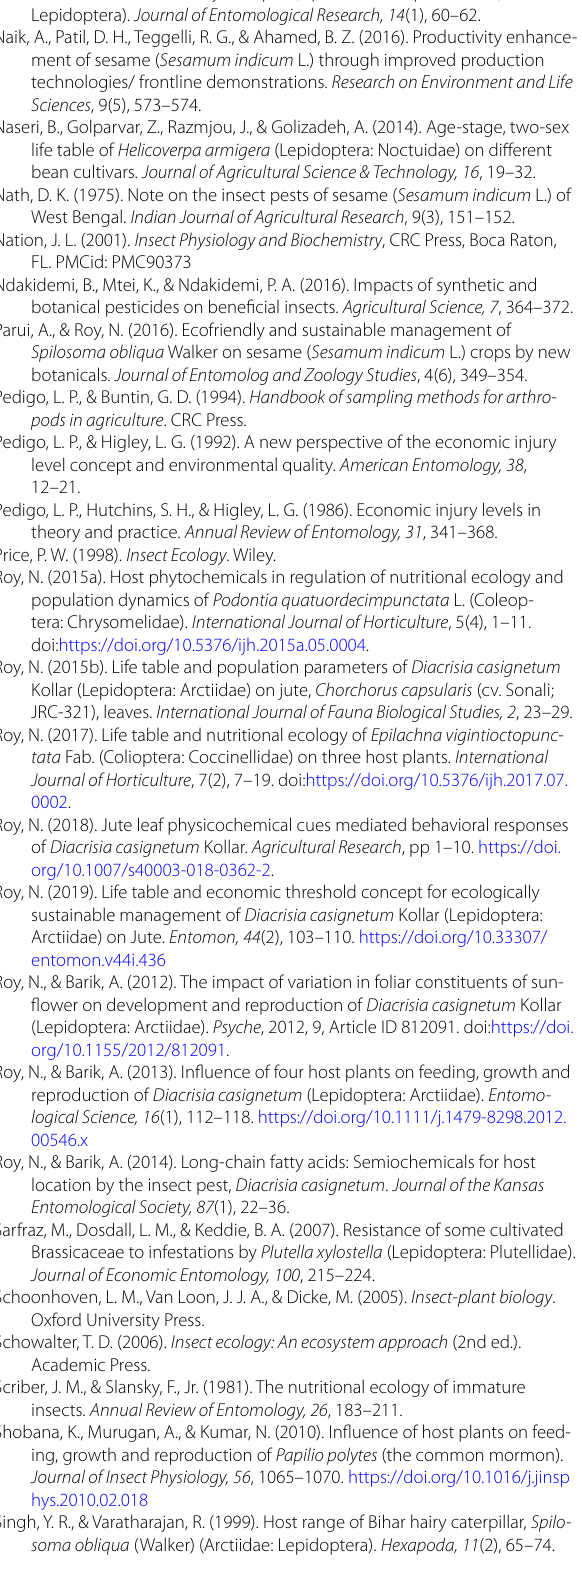
life table of Helicoverpa armigera (Lepidoptera: Noctuidae) on different bean cultivars. Journal of Agricultural Science & Technology, 16 , 19–32. Nath, D. K. (1975). Note on the insect pests of sesame ( Sesamum indicum L.) of West Bengal. Indian Journal of Agricultural Research , 9(3), 151–152. Nation, J. L. (2001). Insect Physiology and Biochemistry , CRC Press, Boca Raton, FL. PMCid: PMC90373 Ndakidemi, B., Mtei, K., & Ndakidemi, P. A. (2016). Impacts of synthetic and botanical pesticides on beneficial insects. Agricultural Science, 7 , 364–372.